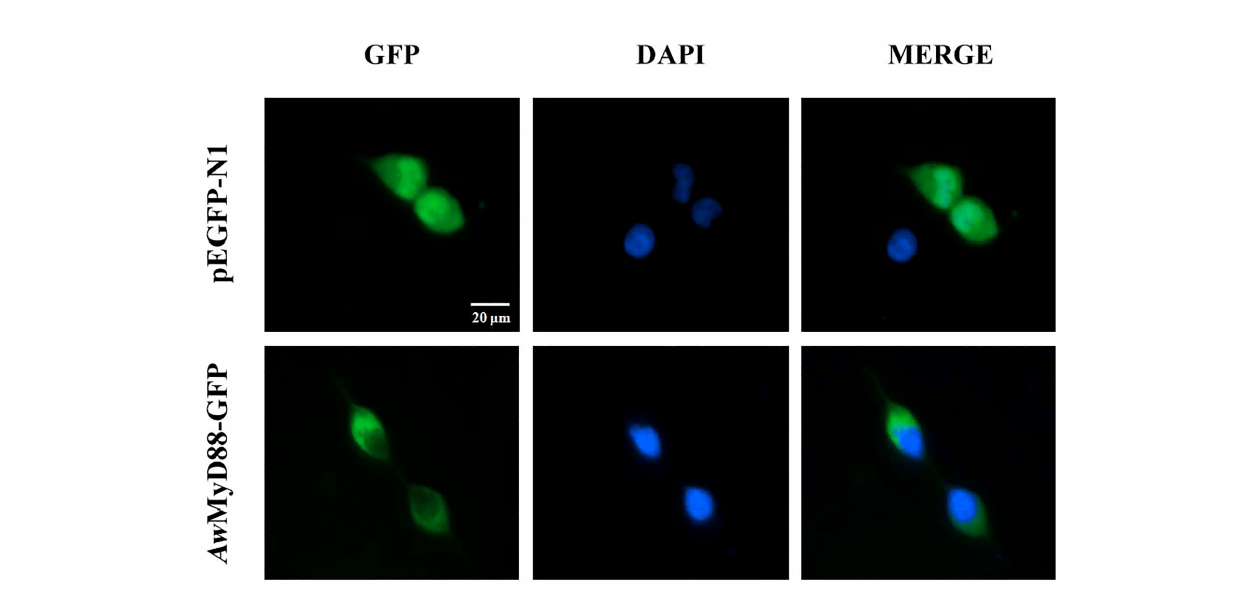
FIGURE 8 | Subcellular localization of Aw MyD88-GFP in HEK293T cells. HEK293T cells were transiently transfected with Aw MyD88-GFP or pEGFP-N1 (control). At 48 h posttransfection, the nucleus was stained with DAPI, and the cells were imaged under a fl uorescence